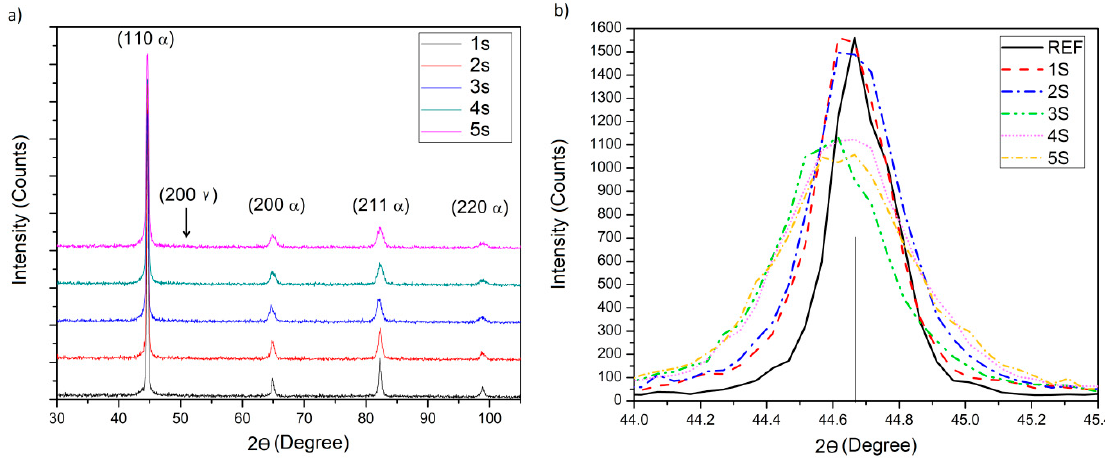
Figure 8. X-ray diffraction pattern ( a ) and close-up of the principal peak (110- α ) ( b ).